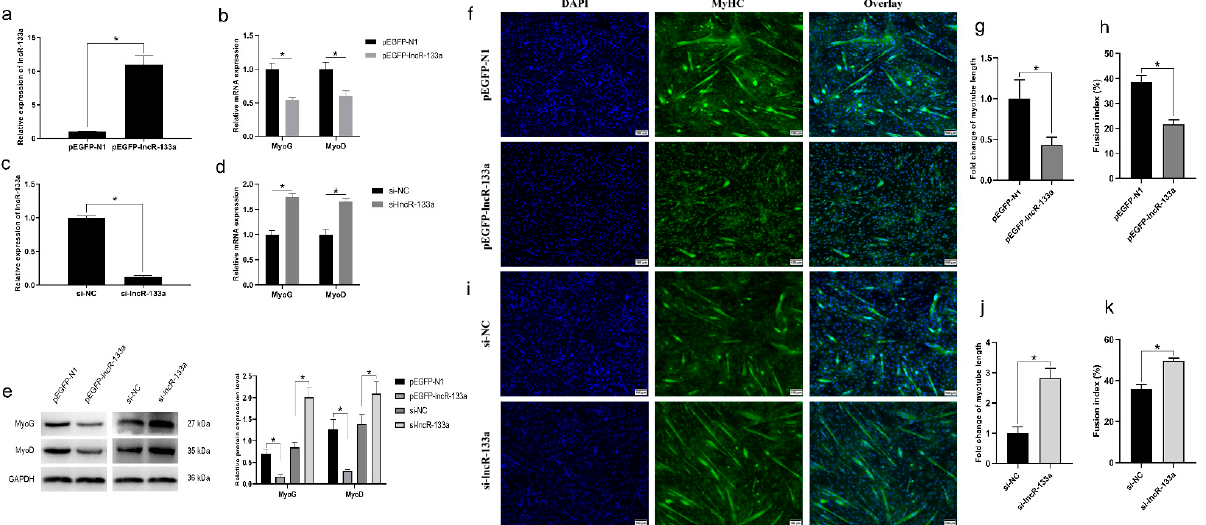
Figure 2. LncR-133a suppresses the differentiation of goat MuSCs. ( a ) The expression levels of lncR-133a were determined in MuSCs transfected with pEGFP-N1 or pEGFP-lncR-133a. ( b ) Muscle differentiation marker genes (MyoG and MyoD) expression levels were determined in MuSCs transfected with pEGFP-N1 or pEGFP-lncR-133a. ( c ) The expression levels of lncR-133a were measured in MuSCs transfected with si-NC or si-lncR-133a. ( d ) The expression levels of muscle differentiation marker genes (MyoG and MyoD) were determined in MuSCs transfected with si-NC or si-lncR-133a. ( e ) MyoG and MyoD protein levels were determined in MuSCs transfected with pEGFP-N1 or pEGFP-lncR-133a, si-NC or si-lncR-133a. Image Pro Plus software (version 6.0, Media Cybernetics) was used to calculate the quantification of protein expression. ( f ) MyHC-stained cells were transfected with pEGFP-N1 or pEGFP-lncR-133a and then cultured in differentiation medium (DM) for 4 days. DAPI stainingwas used to visualize the nuclei of cells (blue). The length ( g ) and fusion index ( h ) of myotubes were determined. Scale bars = 100 μ m. ( i ) Immunofluorescence assay for MyHC-stained cells transfected with si-NC or si-lncR-133a then cultured in DM for 4 days. Cell nuclei were visualized with DAPI (blue). Quantified myotube length ( j ) and fusion index ( k ) Scale bars = 100 μ m. Data are means ± standard error of the mean of at least three biological replicates, * p < 0.05.